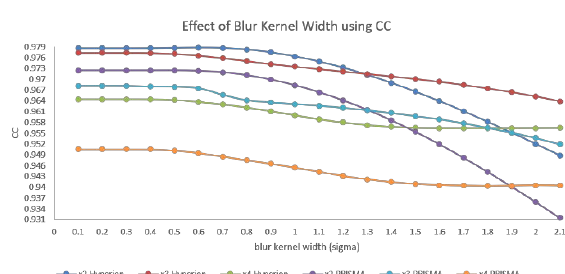
Figure 16. Effect of Blur Kernel Width Using CC on GPR’s Performance CC values are above 0.9 in each scenario. For x4 Hyperion and x4 PRISMA, the values decline from σ = 0.5 to σ = 1.5 and remain unchanged with rising kernel parameters. For SF = 2, the values peak at σ = 0.6 and decline with rising kernel parameters .